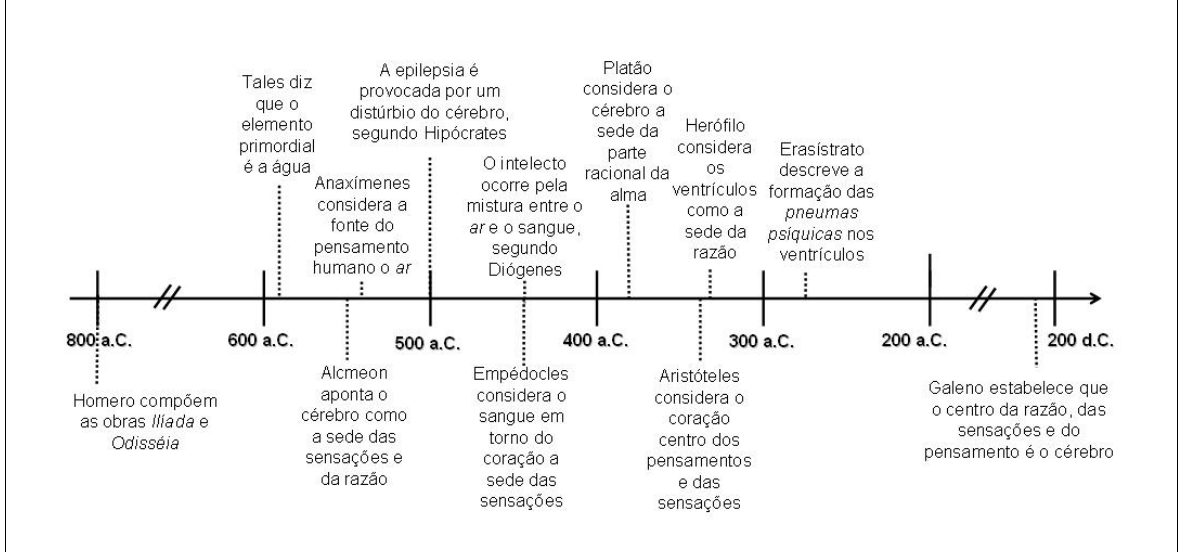
Figura 1 . Linha do tempo dos principais eventos